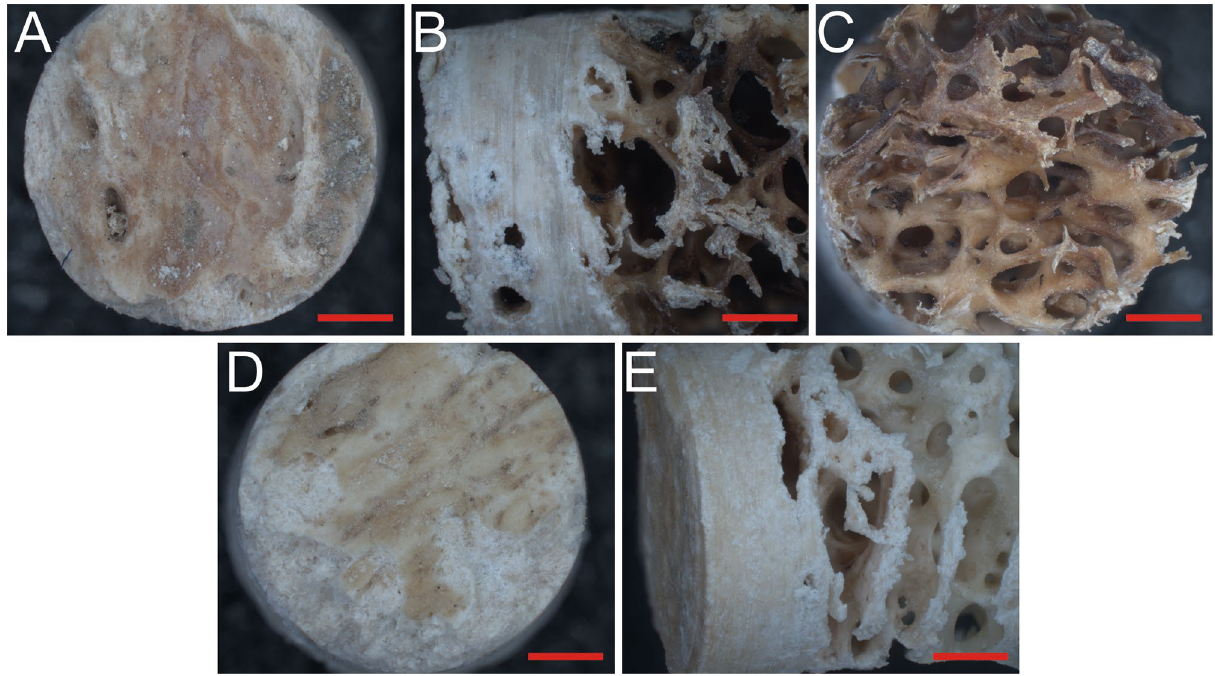
Figure 3. Human osteoarchaeological femora core micro-samples. Microphotographs of unfragmented femur bone cores extracted from two individuals showing the sequence of bone structures in this skeletal element, its distribution, and variation in appearance in human osteoarchaeological material. ( A – C ) Individual SK1089; ( D , E ) Individual SK2. ( A , D ) Detail of periosteal bone from a superficial view; ( B , E ) lateral view showing, from left to right, the periosteal, cortical, and trabecular bone structures; ( C ) detail of trabecular bone from a deep view. Red lines indicate a scale of 1 mm in